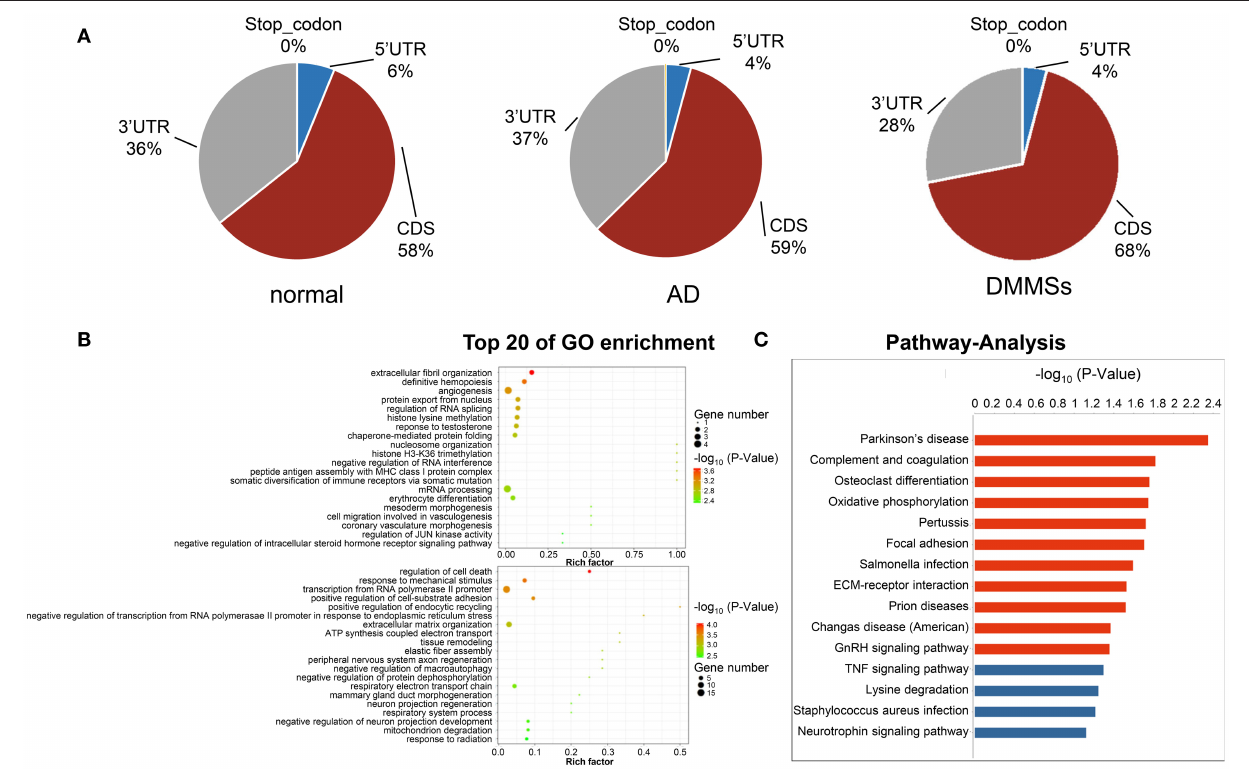
FIGURE 3 | Differentially methylated N6-methyladenosine sites. (A) Pie charts showing the percentage of m6A peaks in five non-overlapping segments of transcripts in normal aorta, aortic dissection (AD) and differentially methylated m6A sites (DMMSs). m6A peaks were mostly enriched in the coding sequence segment. (B) The top twenty gene ontology terms of biological processes showed significant enrichment of up-methylated and down-methylated genes. (C) Bar plot showing the top ten enrichment scores of the significant enrichment pathway for the up- or down-methylated